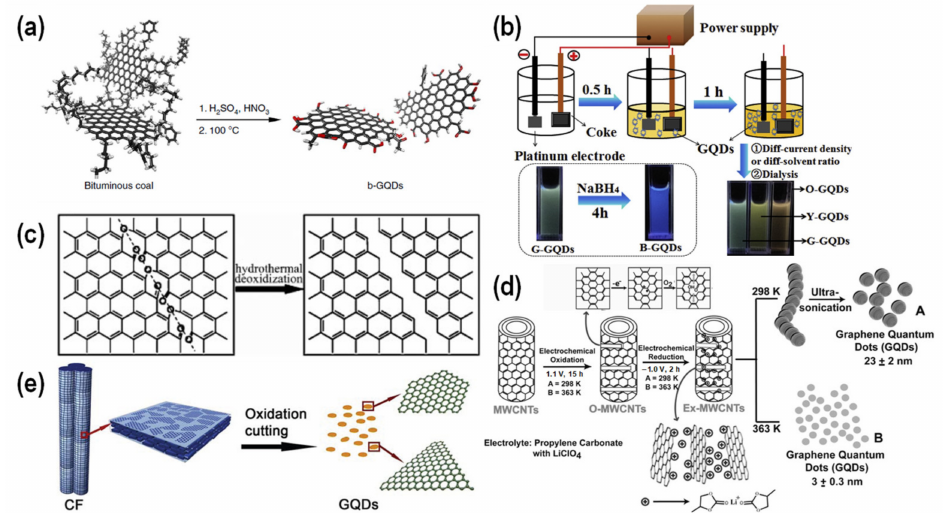
Figure 3. Synthesis of GQDs based on top–down approach. GQDs synthesis from ( a ) coal [42], ( b ) coke [44], ( c ) graphene [6], ( d ) CNT [46] and ( e ) carbon fiber